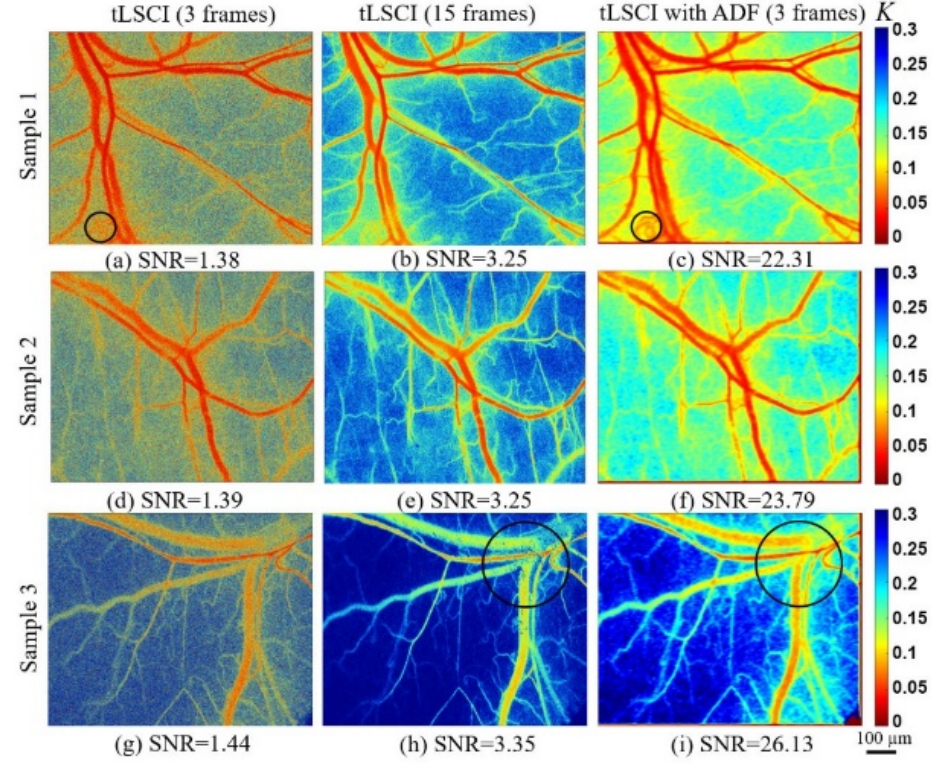
Figure 8. Comparison of temporal contrast image and the ADF.